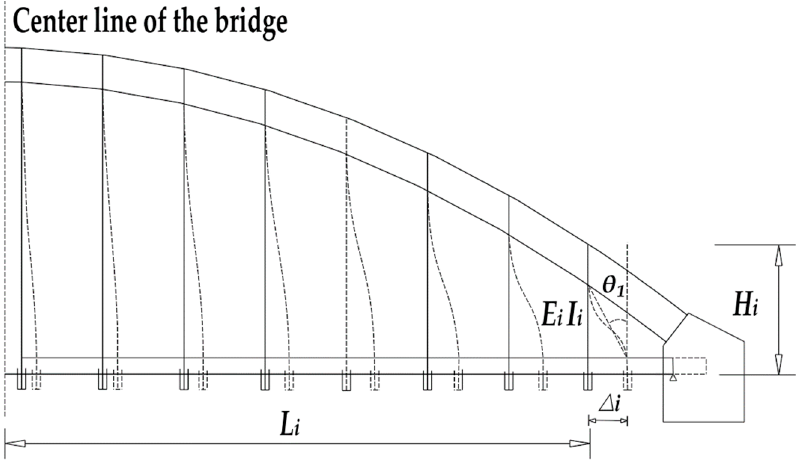
Figure 5. Lateral bending angles caused by the longitudinal deformation of bridge decks. Appl. Sci. 2020 , 10 , x FOR PEER REVIEW